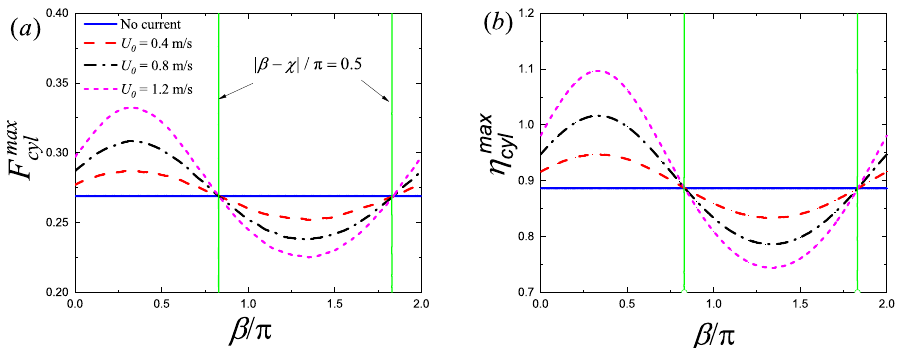
Figure 7. Variation in non-dimensional total wave force and run-up on the interior cylinder for different current speeds U 0 with a / b = 2, a / h = 1, k x / k = 0.5, β = π /3, G = 1, α = 2 π /3, and γ = 2 π /3: ( a ) wave force; ( b ) wave run-up, ka = 4.